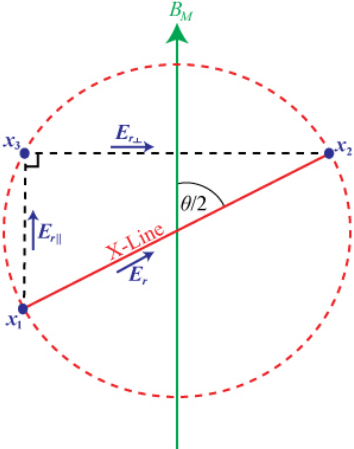
Fig. 1. The components of the reconnection electric field, where the line x 1 x 2 is the length of the X line, l 0